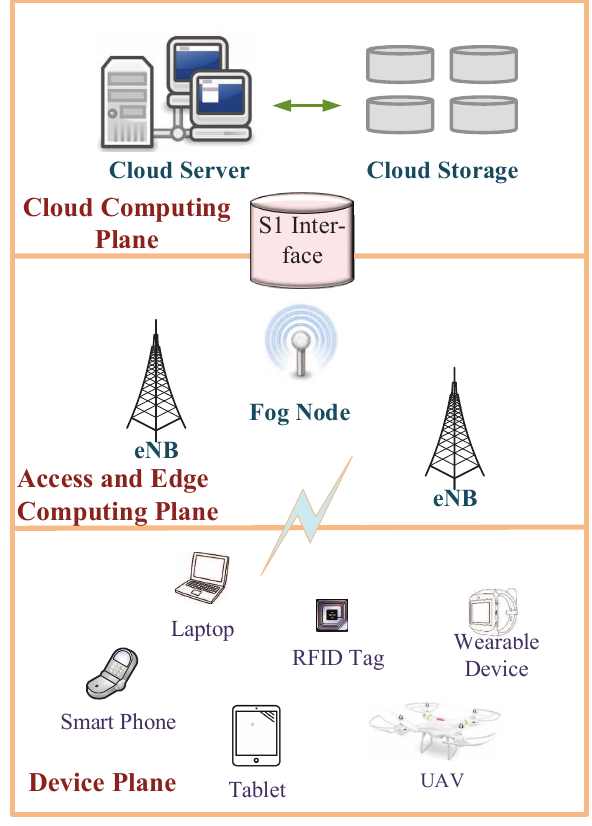
Figure 3. The three-plane C-IoT